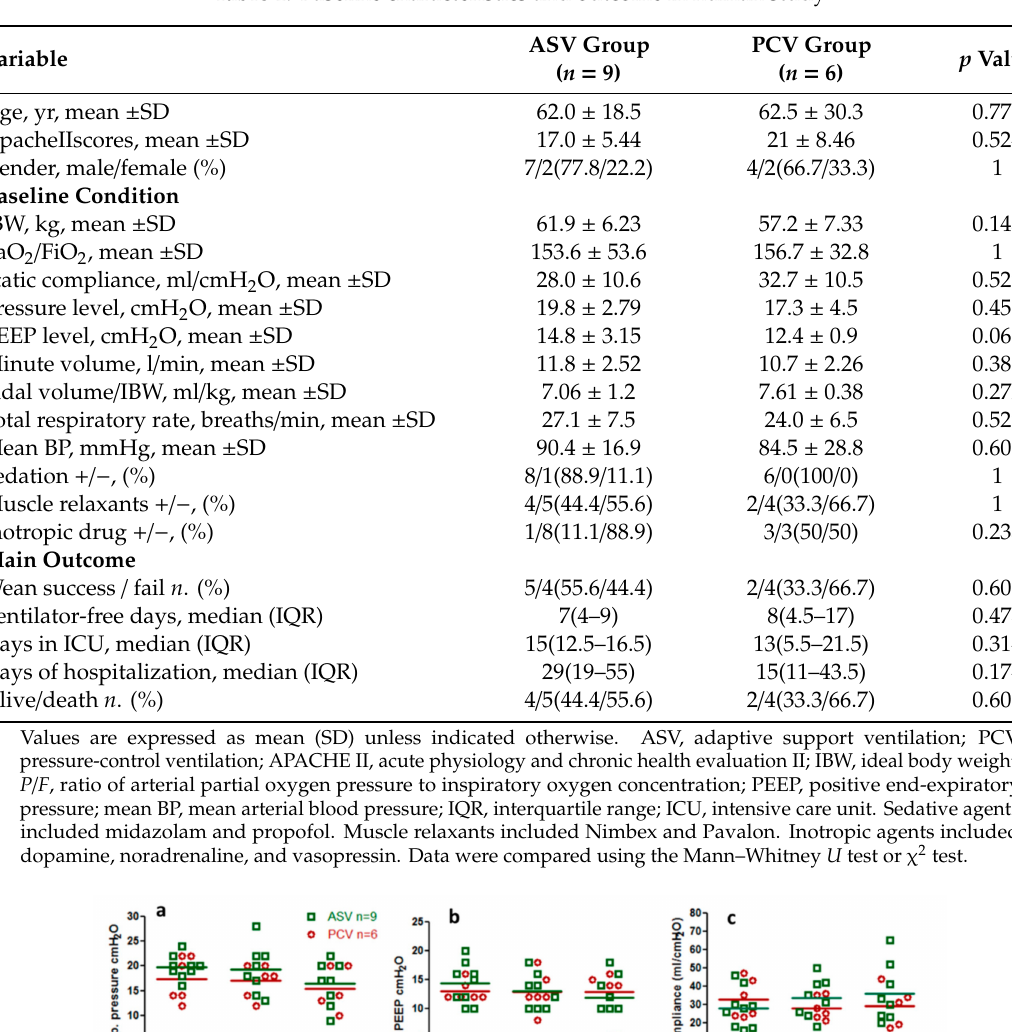
Table 1. Baseline characteristics and outcome in human